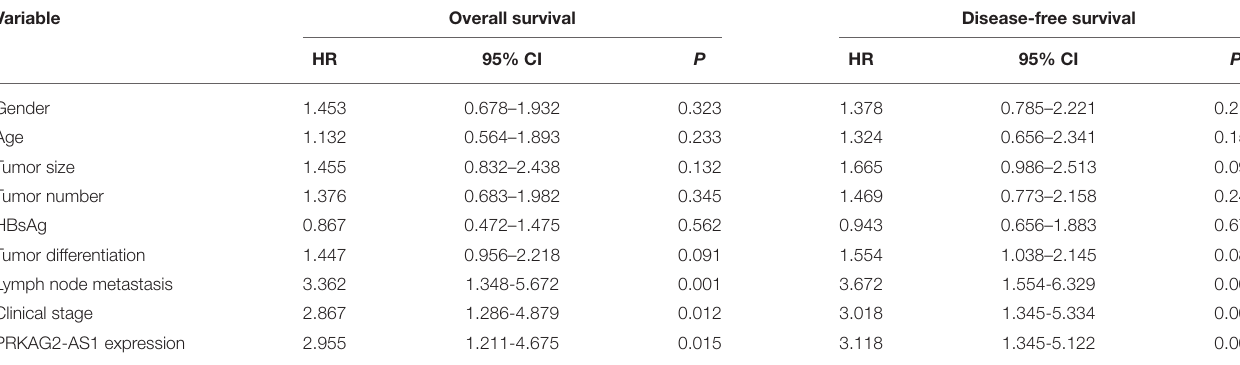
TABLE 3 | Multivariate analyses for overall survival and disease-free survival by Cox regression model.